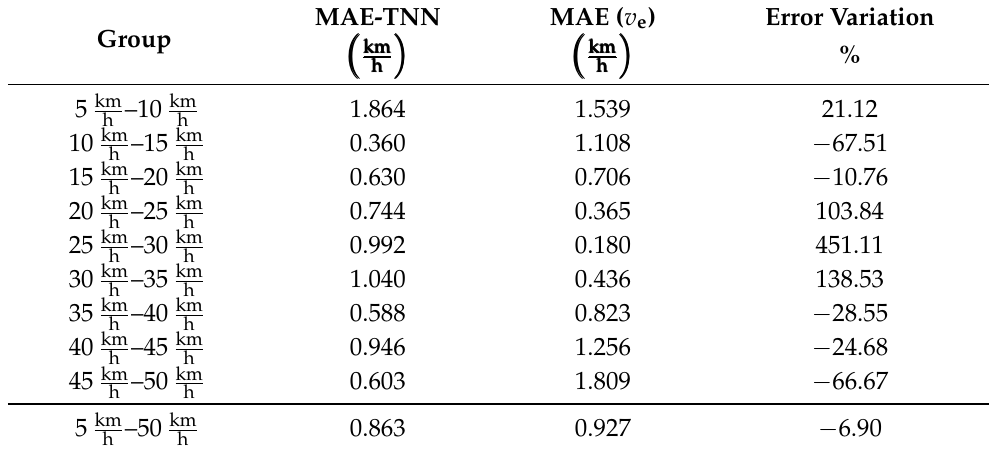
Table 9. MAE for v e vs. v r and the MAE for the inference of the TNN vs. v r . Database size: 1000.